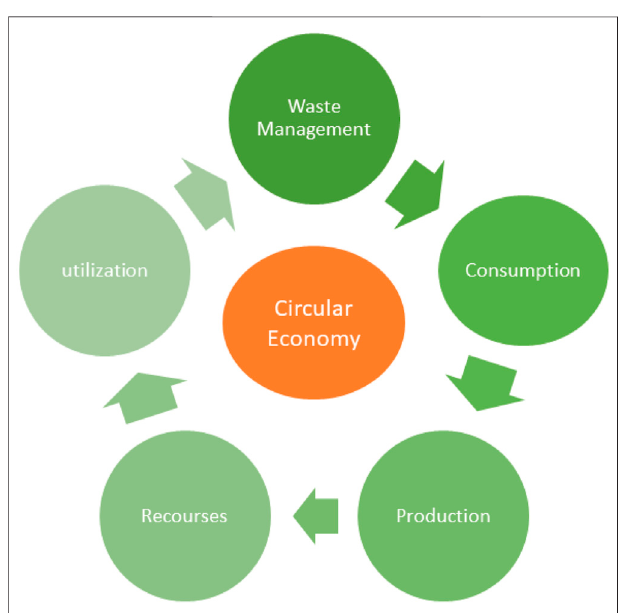
FIGURE 6 | Flow chart of ef fi cient organization of a circular economy. Source: Author Own